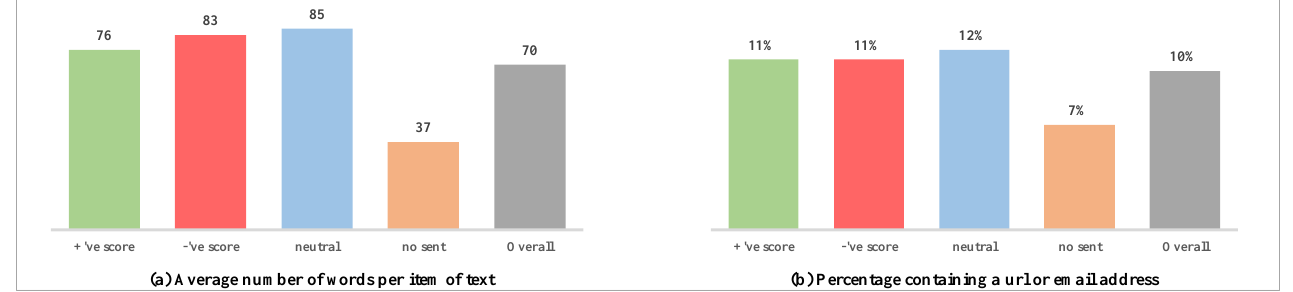
Figure 5. Total items processed and net sentiment. Note: Pos means positive, Neu means neutral, and Neg means negative.